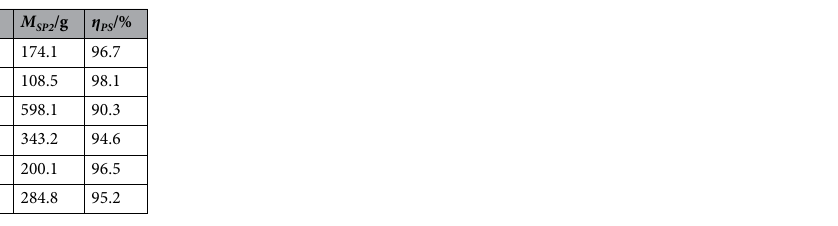
Table 6. Measurement of scattering qualified